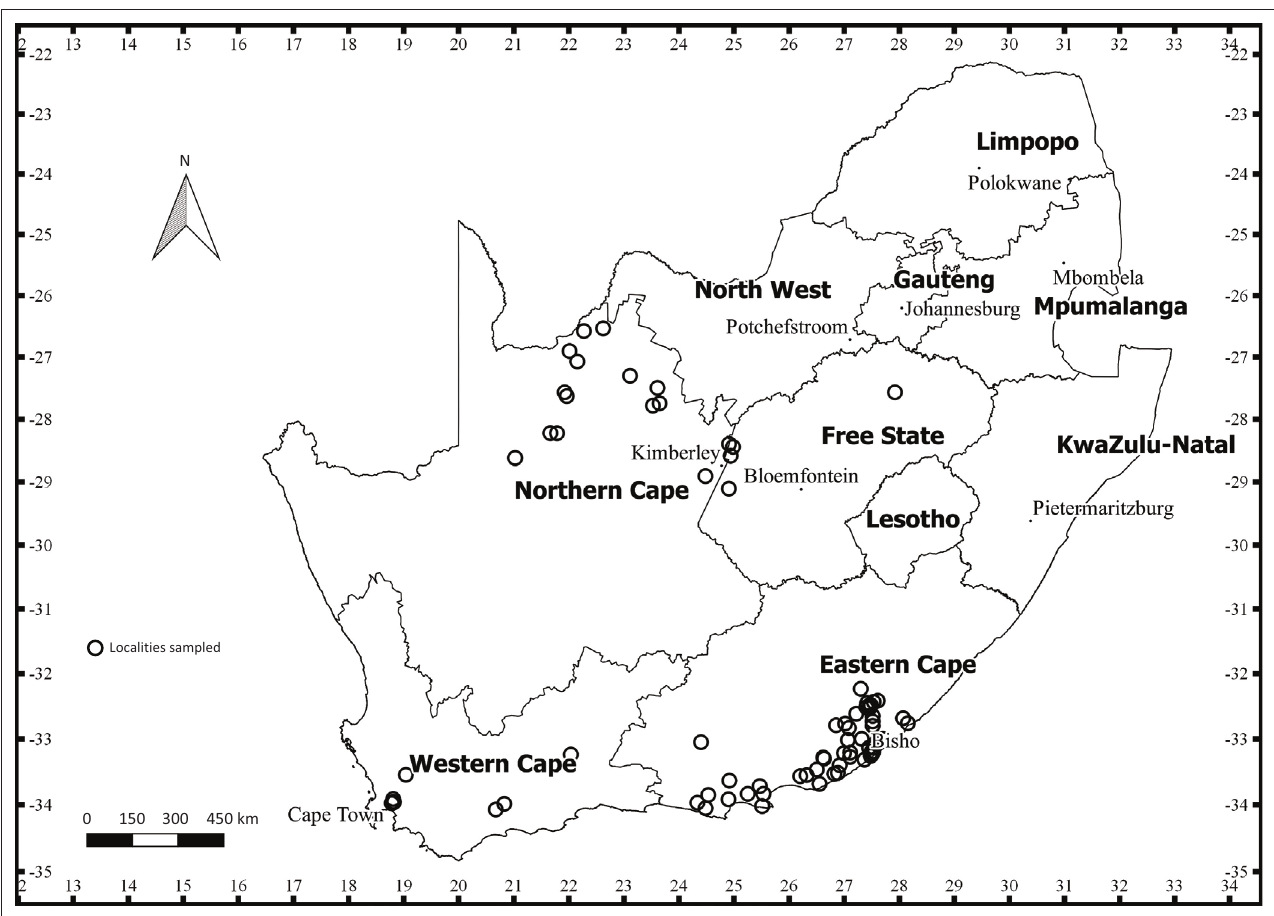
FIGURE 1: Sampling localities where ticks were collected in the Eastern Cape, Northern Cape, Western Cape and Free State provinces in South Africa (2013–2015). TABLE 1: Occurrence data for Rhipicephalus microplus and Rhipicephalus decoloratus from cattle in the Eastern Cape, Northern Cape, Western Cape and Free State provinces in South Africa during 2013–2015.